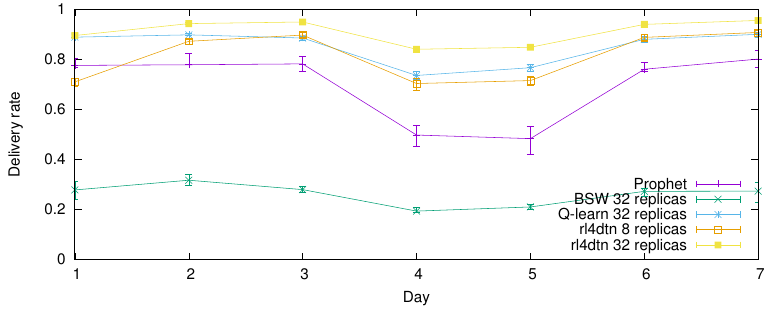
Figure 5. Delivery rate comparison.